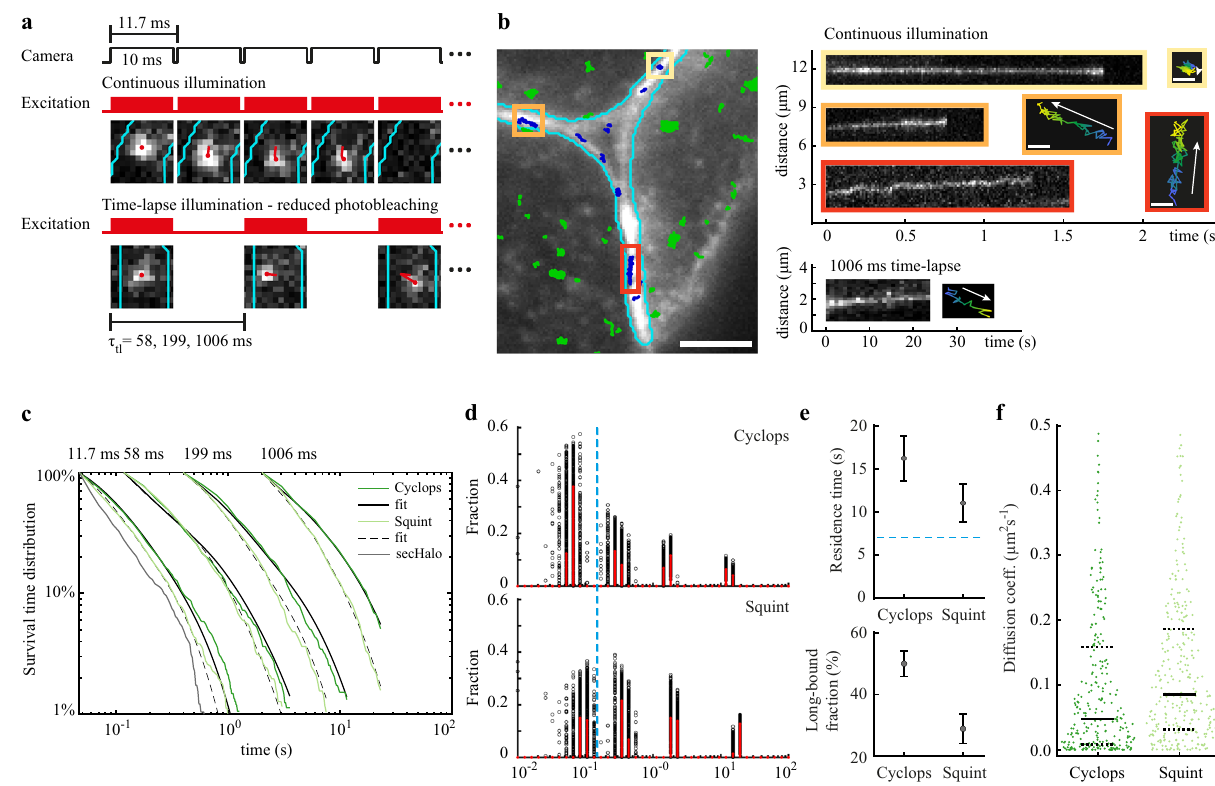
Fig. 4 | Residence times of Cyclops and Squint in the extracellular space. a Overview of camera exposure and laser excitation patterns in time-lapse illumi- nation experiments and representative images of single molecules overlaid with tracks (red) and the boundary of the extracellular region (cyan). b Left panel: OverlayofthememGFPsignal(white)withtheboundaryoftheextracellularregion (cyan) and tracked Cyclops molecules from a movie with continuous illumination. Bound Cyclops molecules in the extracellular space shown in blue, intracellular molecules shown in green. Scale bar: 5 µ m. Right panels: continuous illumination kymographs of the yellow, orange and red regions indicated in the left image and belowakymographfroma1006mstime-lapsemovieaswellaspositionplotsofthe tracks color-coded according to start (blue) and end (yellow) times. Scale bar: 0.3 µ m. c Survival-time distributions of bound morphogens and sec-Halo in the time-lapseconditionsindicatedontop(darkandlightgreenlines)andsurvivaltime functionsobtainedbyGRIDforCyclops(solidblacklines)andSquint(dashedblack